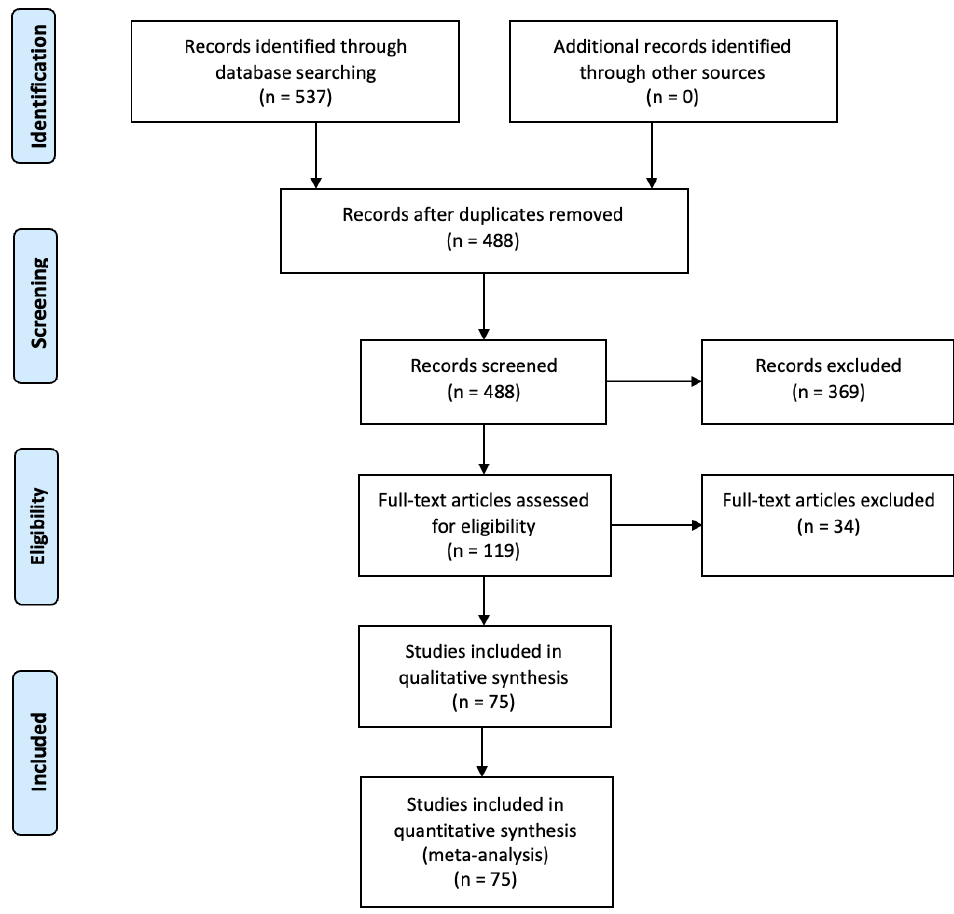
Figure 1. PRISMA flow diagram detailing the systematic search process.